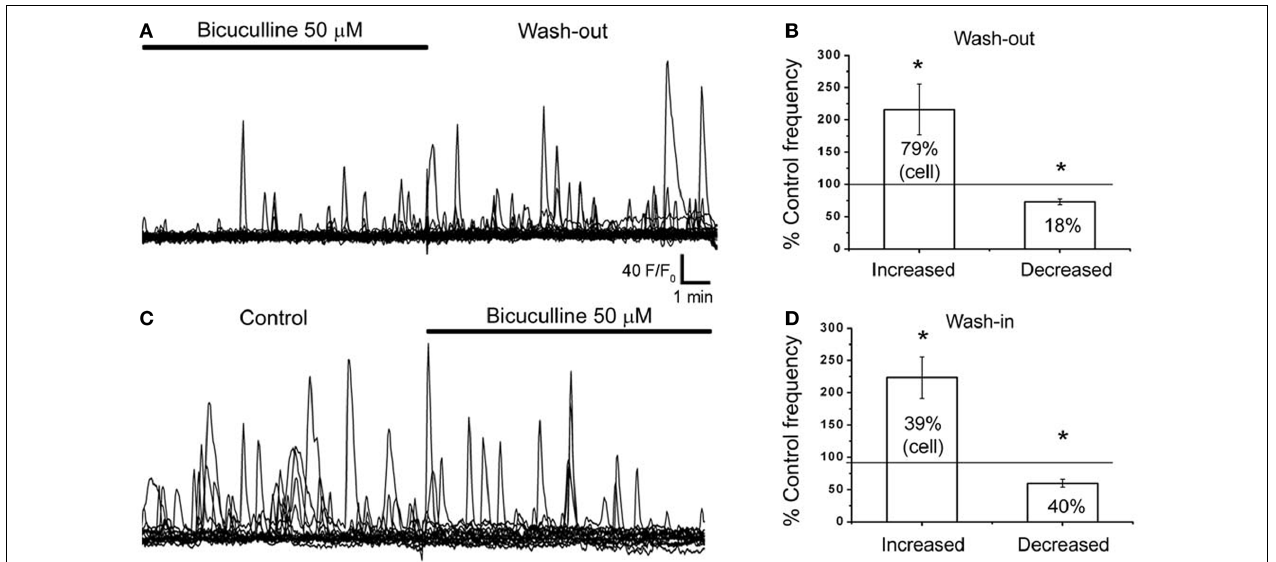
FIGURE 5 | Spontaneous Ca 2 + activity in SVZ astrocytes are sensitive to GABA receptor inhibition. (A,C) Representative traces of spontaneous Ca 2 + A activity from SVZ astrocytes before and after bicuculine (50 µM) wash-out (A) or wash-in (C) . (B) Bar graphs showing that 79% of SVZ astrocytes show an